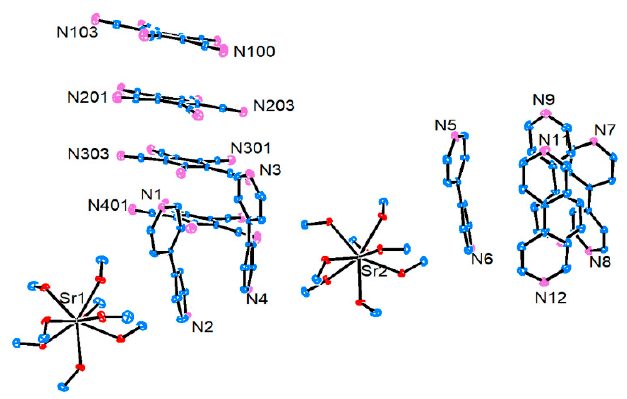
Figure 9 . The asymmetric unit of compound 3 . Thermal ellipsoids are drawn at the 30% probability level.